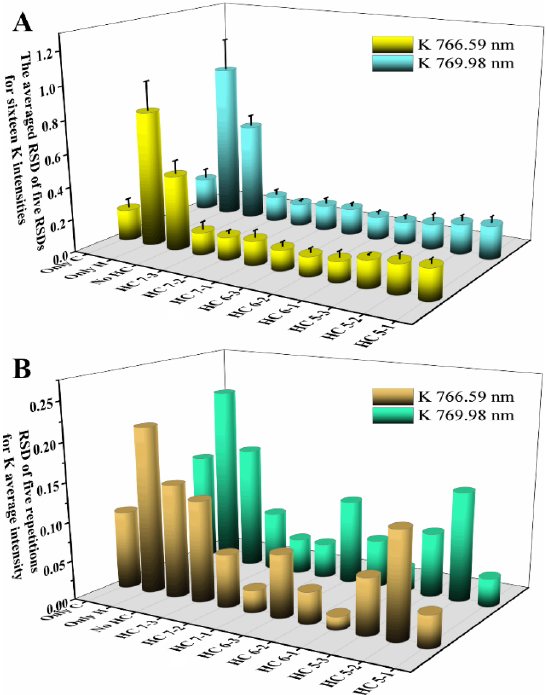
Figure 6. ( A ) The averaged RSD of five RSDs for 16 K intensities at 766.59 and 769.98 nm, respec- tively. The error bars are the standard deviations of five RSDs; ( B ) the RSD of five repetitions for K average intensity at 766.59 and 769.98 nm, respectively.